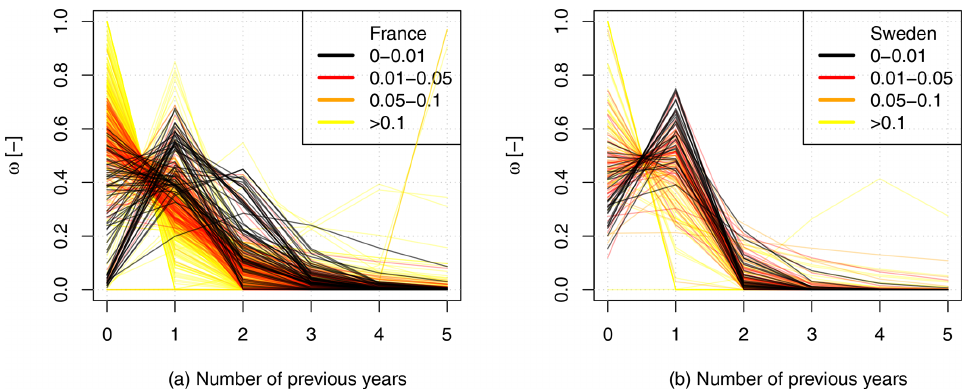
Figure 3. Catchment Forgetting Curves identified for the catchments on our French (a) and Swedish (b) dataset. The black lines represent the catchments where the multi-year CFC is very significant, and the color gradient represents, for the rest of the catchments, the p value of the t